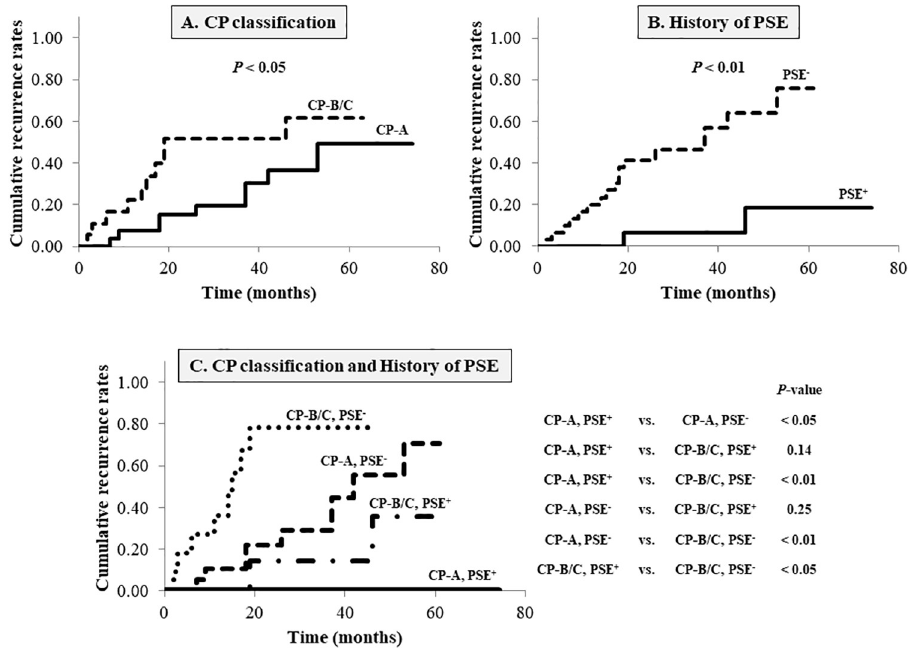
Fig 2. Cumulative recurrence rates of esophageal varices (EV) after endoscopic treatment (ET) according to the pretreatment Child-Pugh (CP) classification and/or a history of partial splenic embolization (PSE). (A), The cumulative recurrence rates of EV in the CP class A patients were significantly lower than those in the CP class B or C patients ( p < 0.05). (B), ET combined with PSE significantly reduced posttreatment variceal recurrence compared with ET alone ( p < 0.01). (C), During follow-up, there were no recurrences of EV after ET combined with PSE in the CP class A patients, and ET alone without PSE in the CP class B or C patients was associated with a significantly highest incidence of variceal recurrence. CP-A, Child-Pugh class A; CP-B/C, Child-Pugh class B or C; PSE, partial splenic embolization.